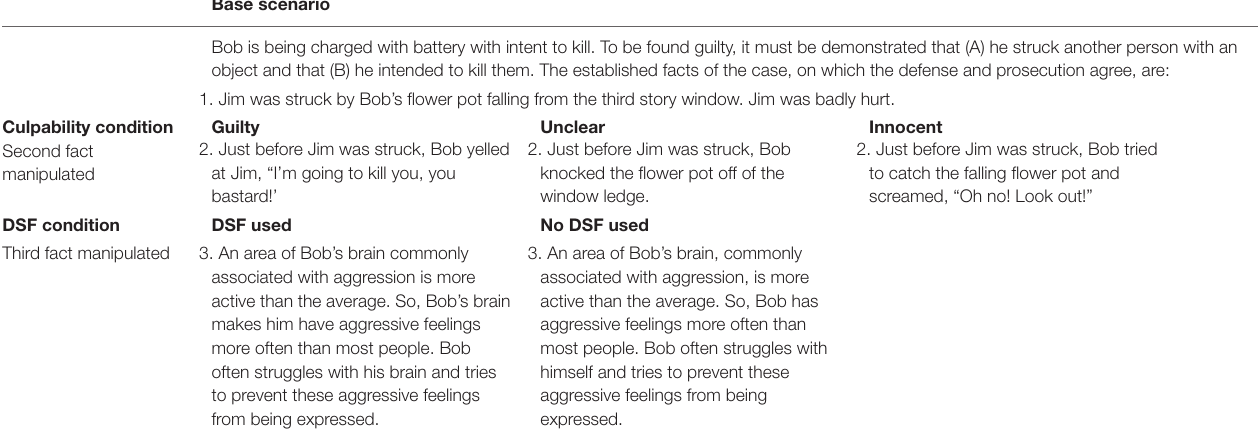
TABLE 2 | Experiment 2 vignette manipulation by condition. Base